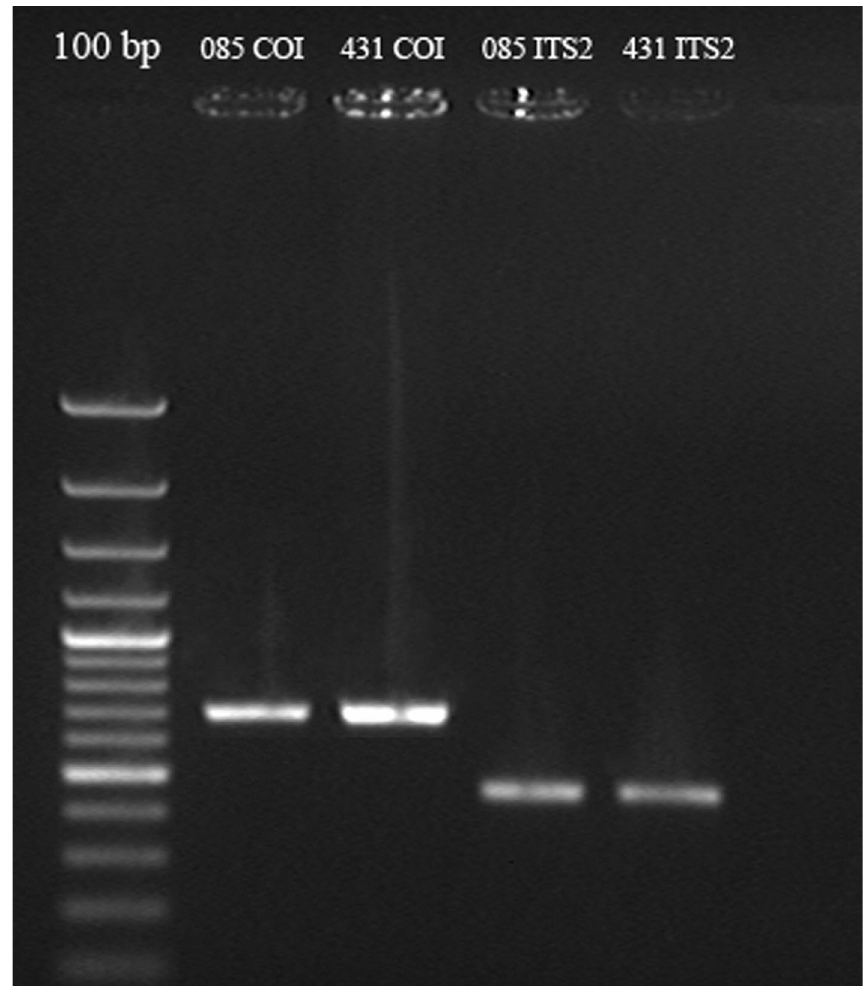
Figure 2. Gel electrophoresis with COI and ITS2 PCR products showing the length of the